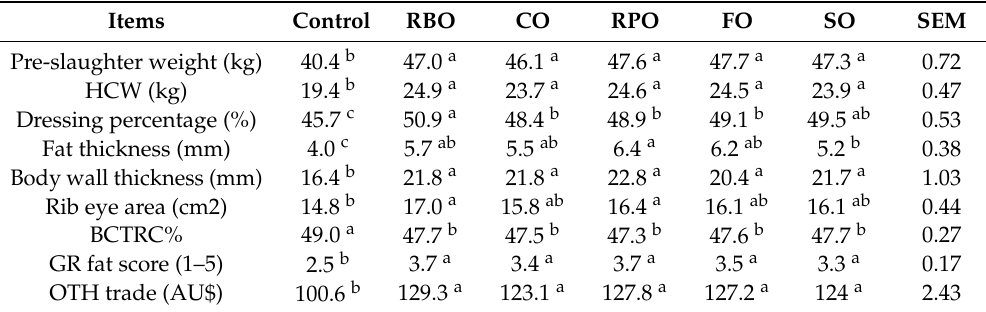
Table 4. Carcass characteristics of prime lambs fed various PUFA enriched pellets